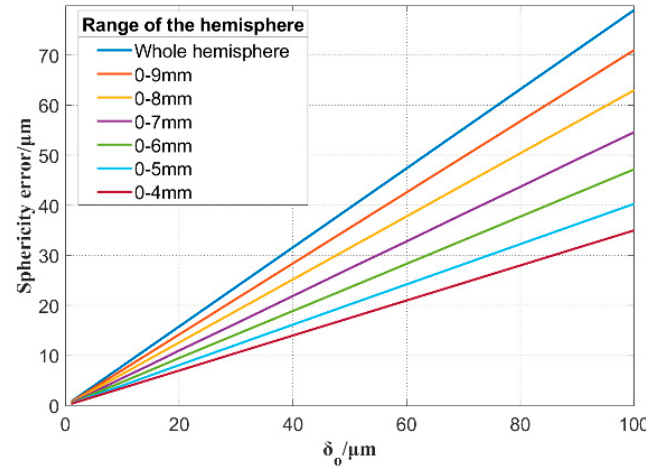
Figure 8. Sphericity error of different ranges of the hemisphere caused by height error.